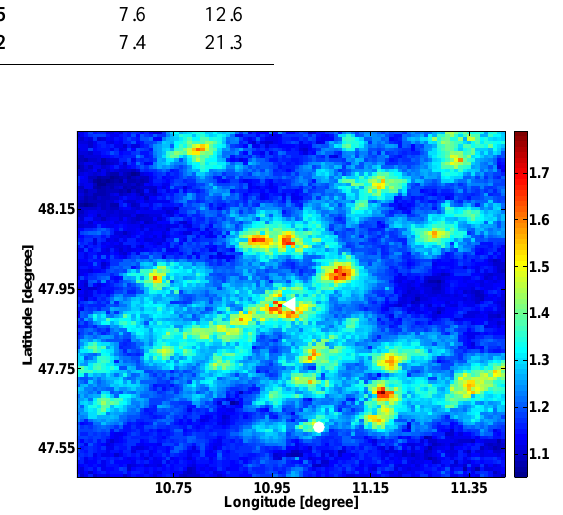
Fig. 7. Maximum Theta map derived from all gauge stations Fig. 7: Maximum Theta map derived from all gauge sta- in the domain. The position of Hohenpeissenberg (Garmisch- tions in the domain. The position of Hohenpeissenberg Partenkirchen) is indicated by a white triangle (circle).